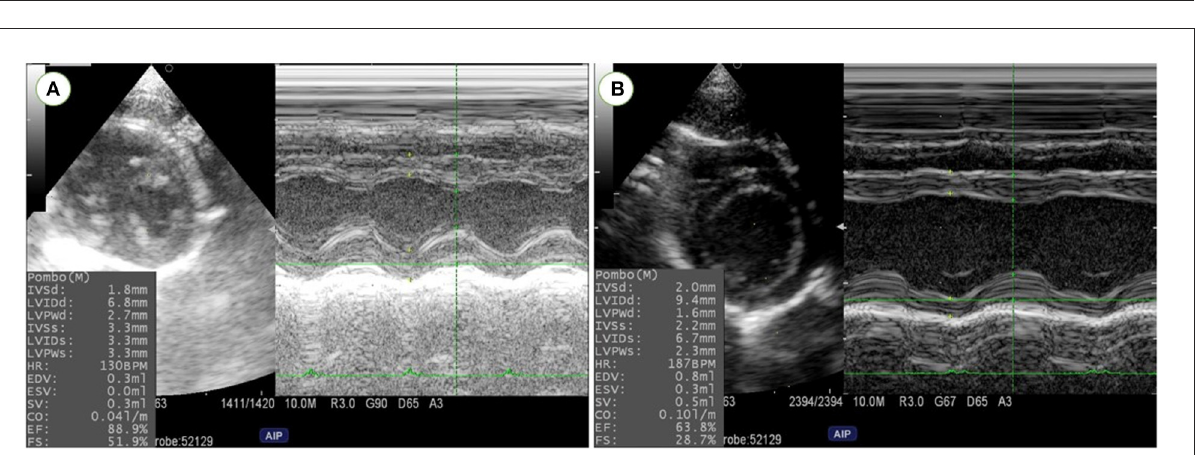
FIGURE6 Left ventricular dimensions and function were evaluated using M-Mode echocardiography at right parasternal short axis in rats before MI induction (A) and one-month post-MI (B) . Reduction in left ventricular wall thickness and cardiac function and increase in left ventricular diameters were confirmed in MI model